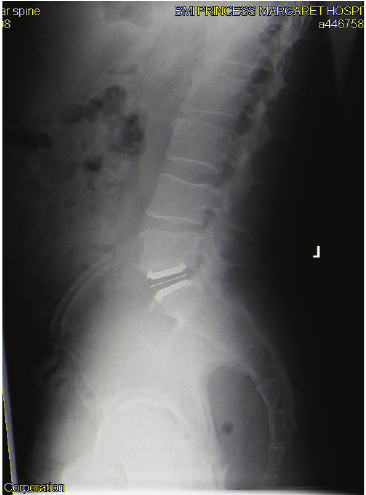
Figure 1: Plain films showing initial placement of total disc replacement.